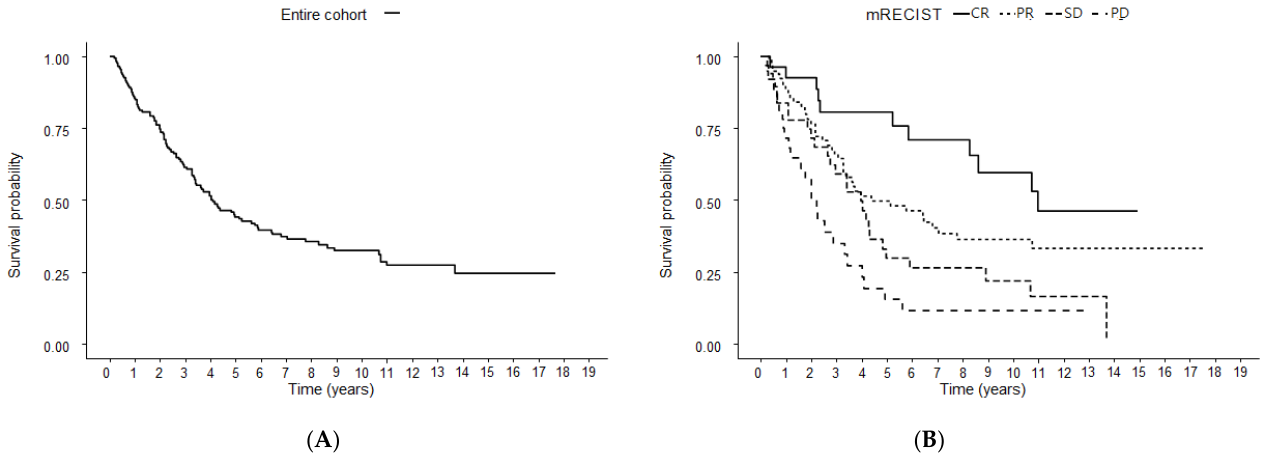
Figure 2. Kaplan-Meier survival curve from baseline ( A ) and after 1st TACE ( B ). TACE, transarterial chemoembolization. Modified Response Evaluation Criteria in Solid Tumors. Complete response, CR; partial response, PR; stable disease SD; and progressive disease; PD.